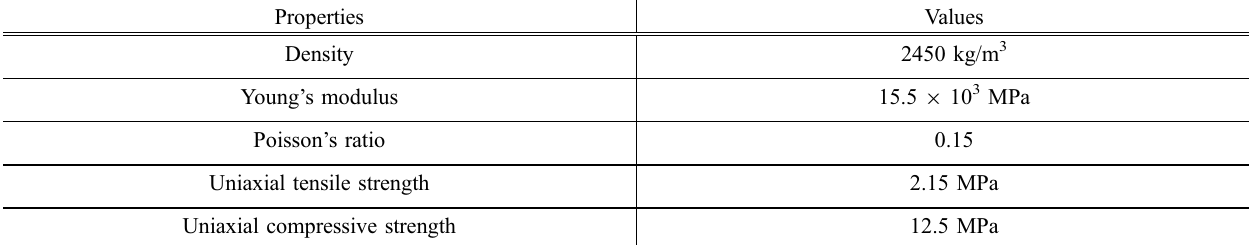
Fig. 23 ASR strains in the concrete outerpack of dry cask structure. Table 6 Concrete properties for tip-over